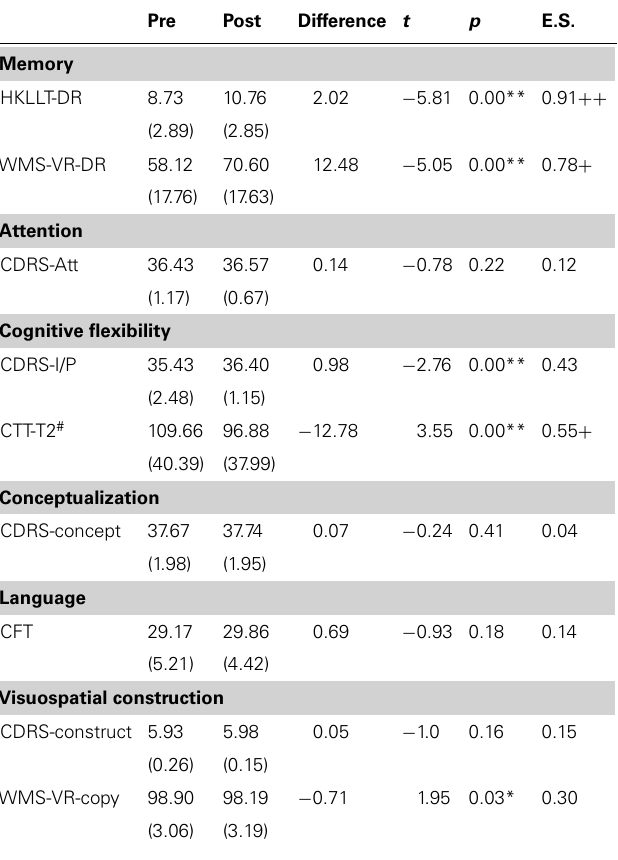
Table 3 | Distribution of participants in the low performers with and without clinically significant changes in memory performance after intervention.